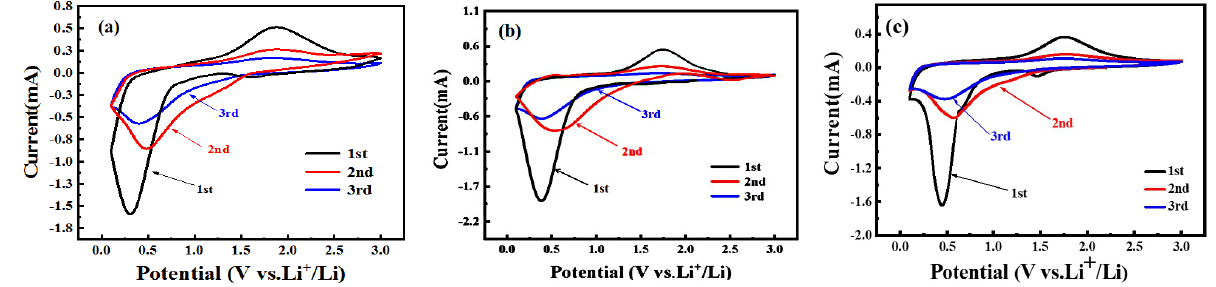
Figure 6: Cyclic voltammetry curves of Fe 2 O 3 /rGO anode materials prepared by three hydrothermal processes